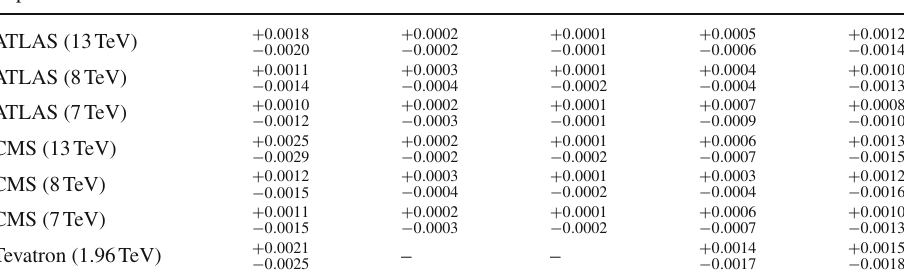
Table 15 As in Table 14, but Exp. δ Syst. (cid:5) now using NNLO + NNLL cross sections with the CT14 PDF set